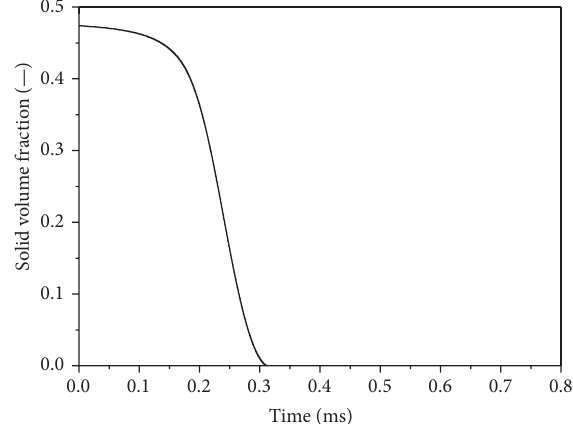
Figure 7: Solid volume fraction-time history for 𝑚 𝑝 = 0.245 g, without barrel friction.